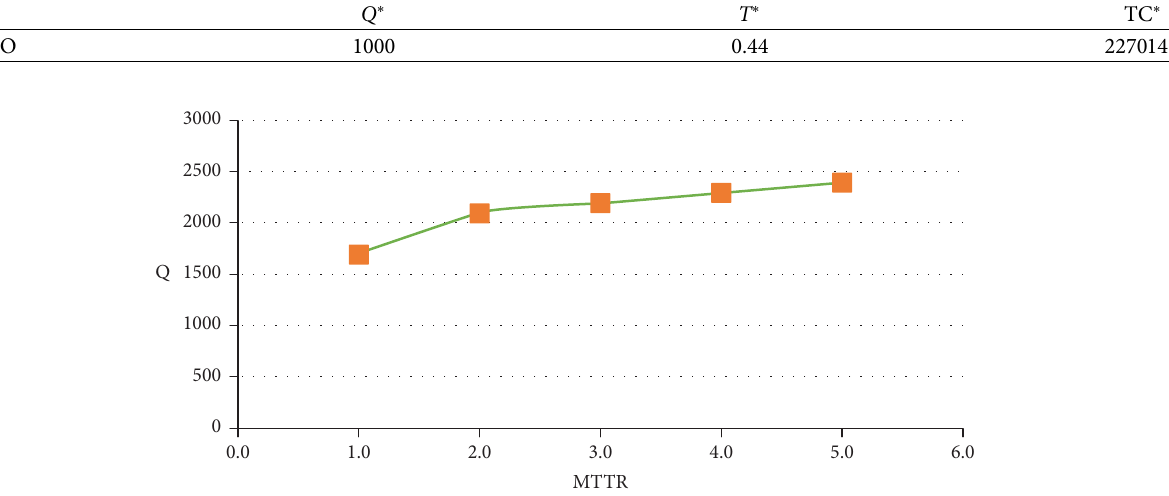
Figure 4: Te efect of MTTR on the amount of economic production